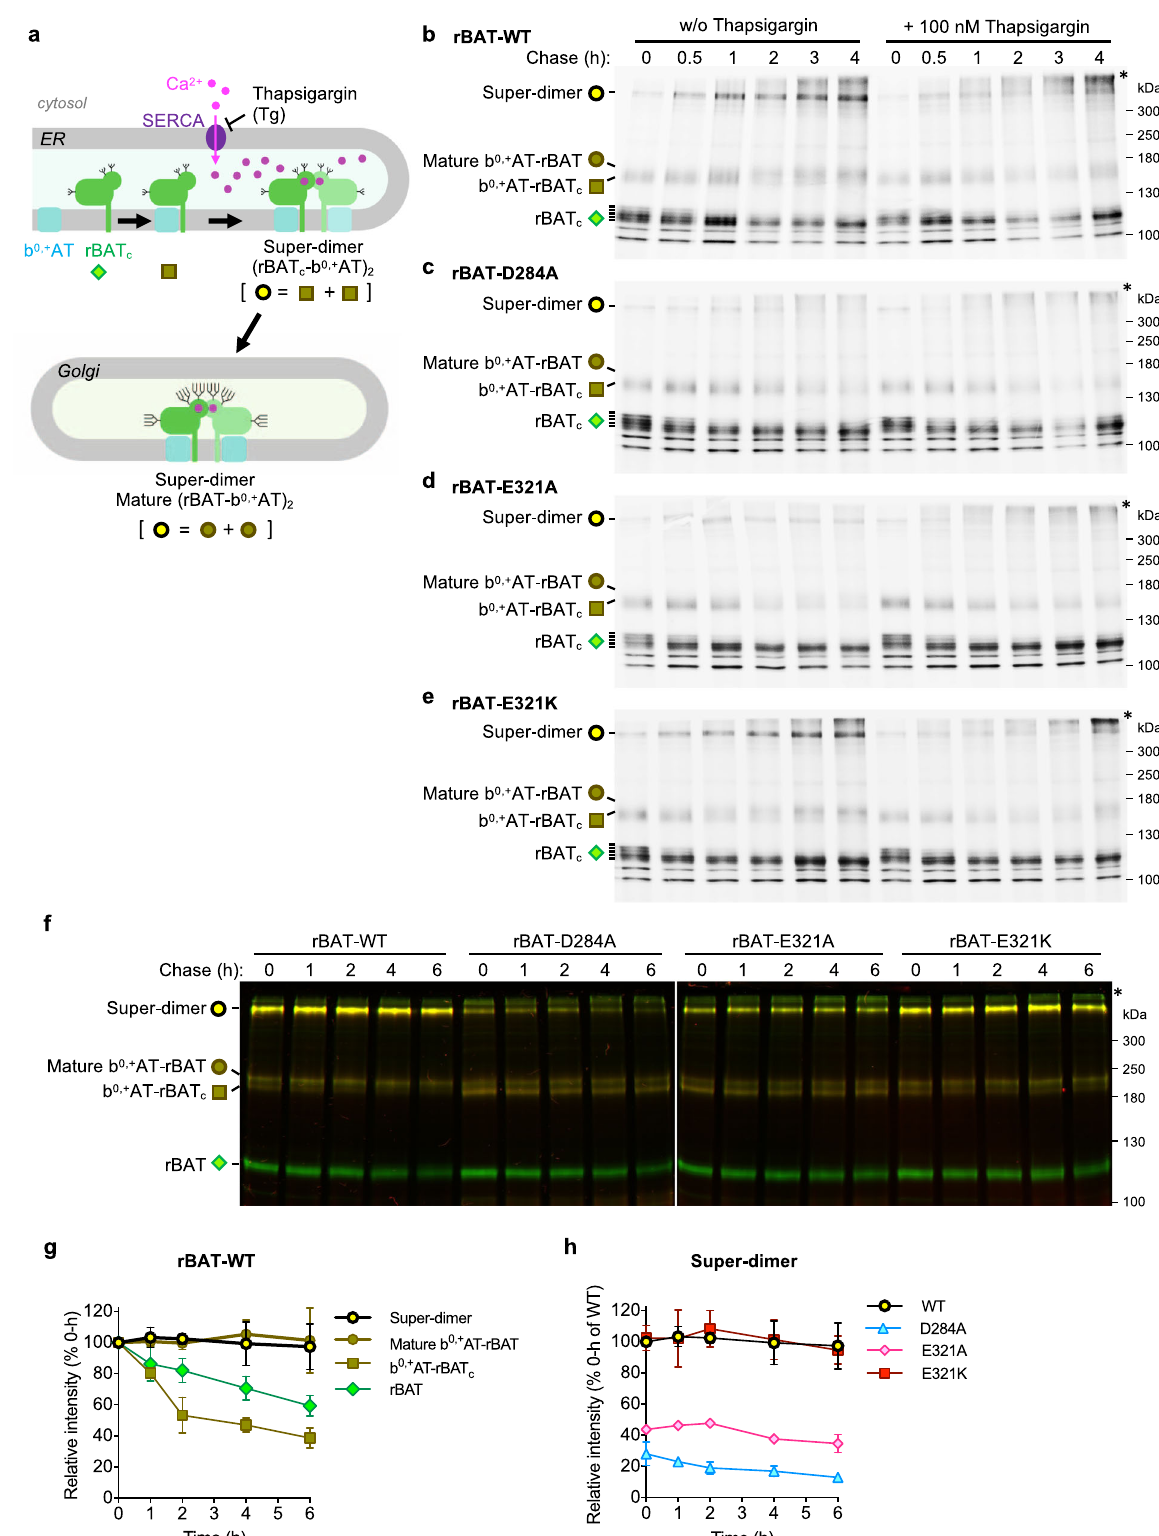
super-dimers and mature b 0, + AT-rBAT heterodimers (Fig. 6b: lanes 10 – 12; Supplementary Fig. 12a). At the late time and high concentration of Tg, the aggregations were observed at the top of the gels, suggesting protein instability and degradation from the failure of super-dimerization (Fig. 6b: lanes 11 – 12; Supplemen- tary Fig. 12a). The effective concentration of Tg for